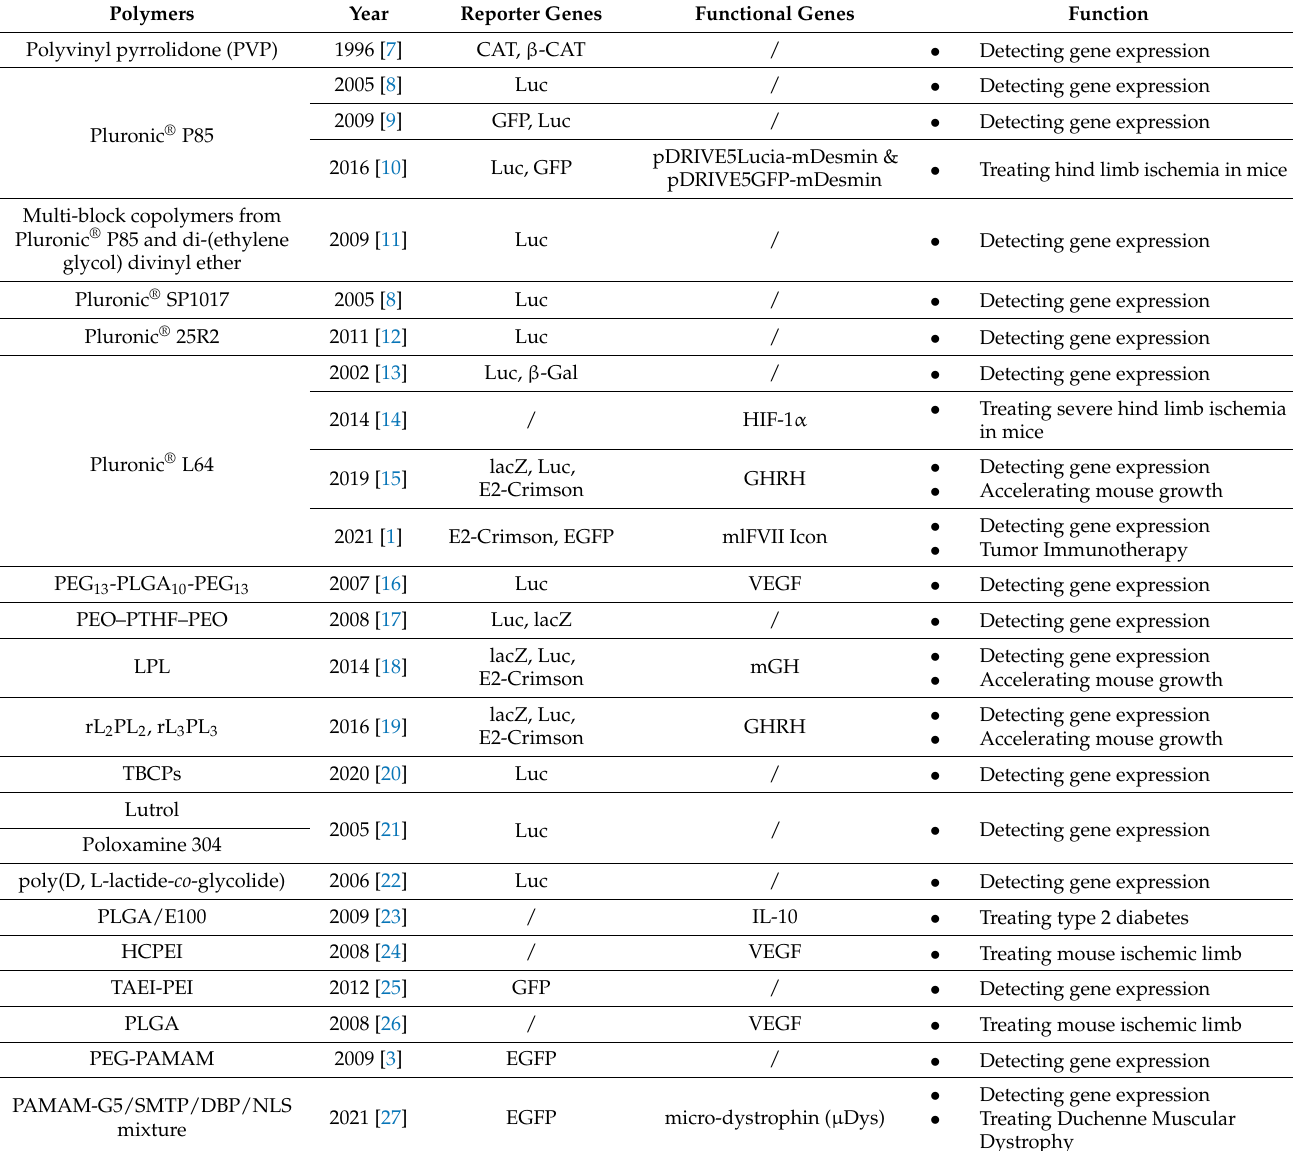
Table 1. Polymers for gene delivery to skeletal